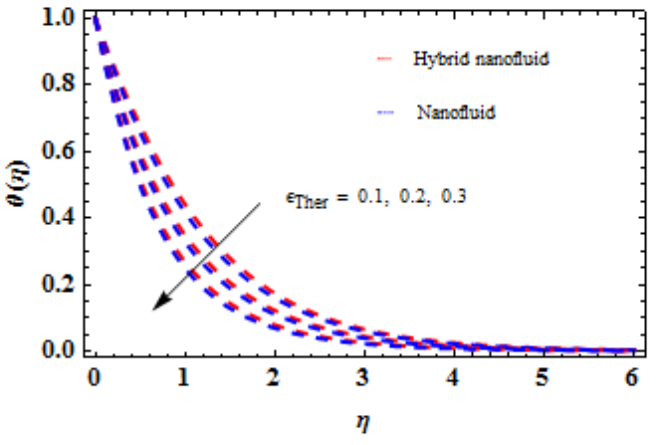
Figure 19. Influence of 𝑀 𝑑 via dust velocity.